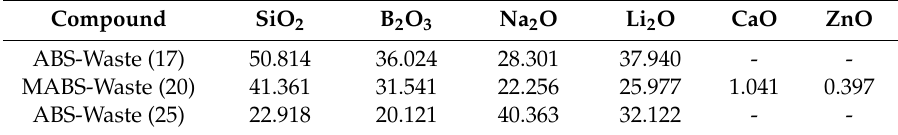
Table 6. Normalized release rate (mg · m − 2 · d − 1 ) for waste components: Alkali, alkaline, post-transitions, and metalloids.